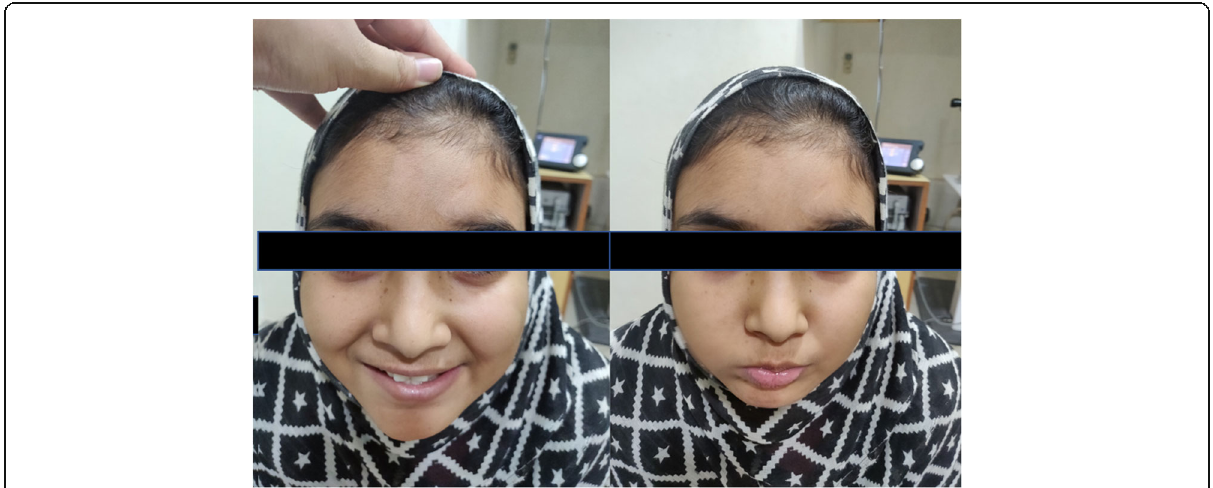
Fig. 1 Photograph of patient showing residual facial palsy(deviation of angle of moth and decreased action of buccinator muscle supplied by facial nerve)